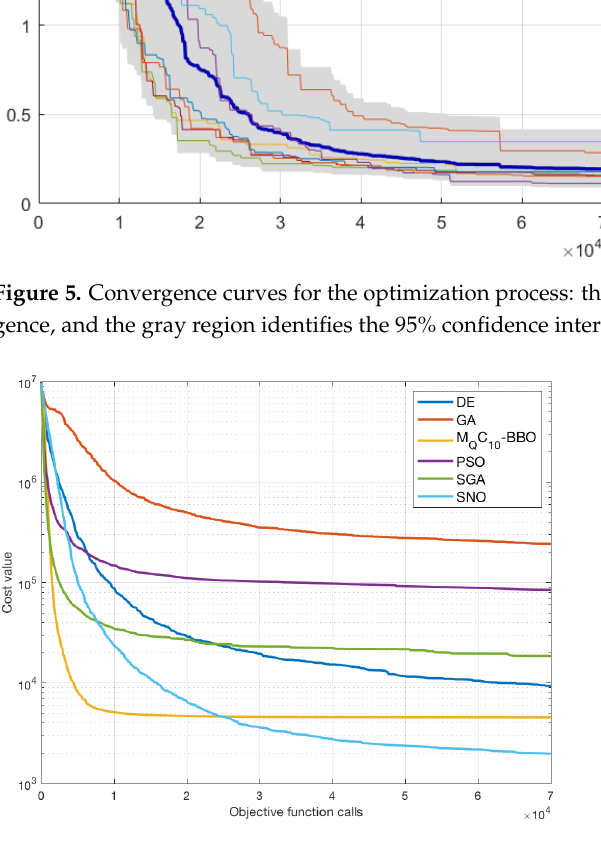
Figure 6. Comparison between the curves of convergence resulting by the application of different algorithms to the problem considered here.